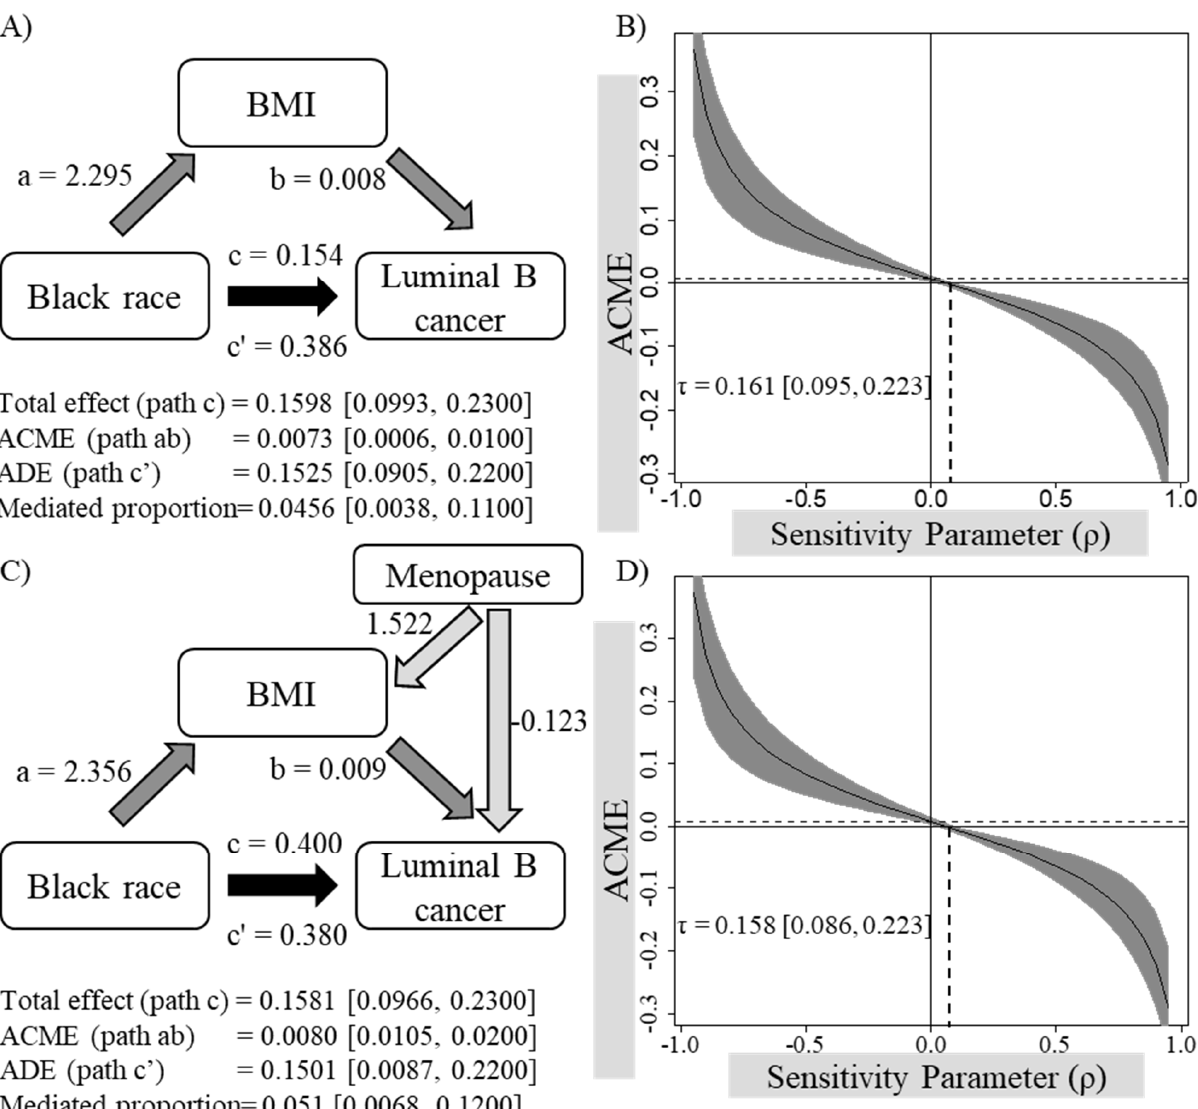
Figure 1. Model diagrams ( A , C ) and sensitivity plots ( B , D ) of the mediation analyses examining whether the association between Black/African American race and Luminal B breast carcinoma is mediated by BMI before ( A , B ) and after ( C , D ) controlling for the menopausal status. ACME, average causal mediation effect; ADE, average direct effect; a, regression coefficient between Black/African American race and BMI; b, regression coefficient between BMI and Luminal B cancer when controlled for Black/African American race; c, regression coefficient between Black/African American race and Luminal B cancer; c’, regression coefficient between Black/African American race and Luminal B cancer when controlled for BMI; τ , sensitivity parameter required to nullify ACME. Confidence intervals have been obtained using a non-parametric bootstrap approach (1000 simulations). Light colored arrows arising from the covariate Menopause represent the regression coefficients between Menopause and each outcome variable (i.e., BMI and Luminal B cancer) in each